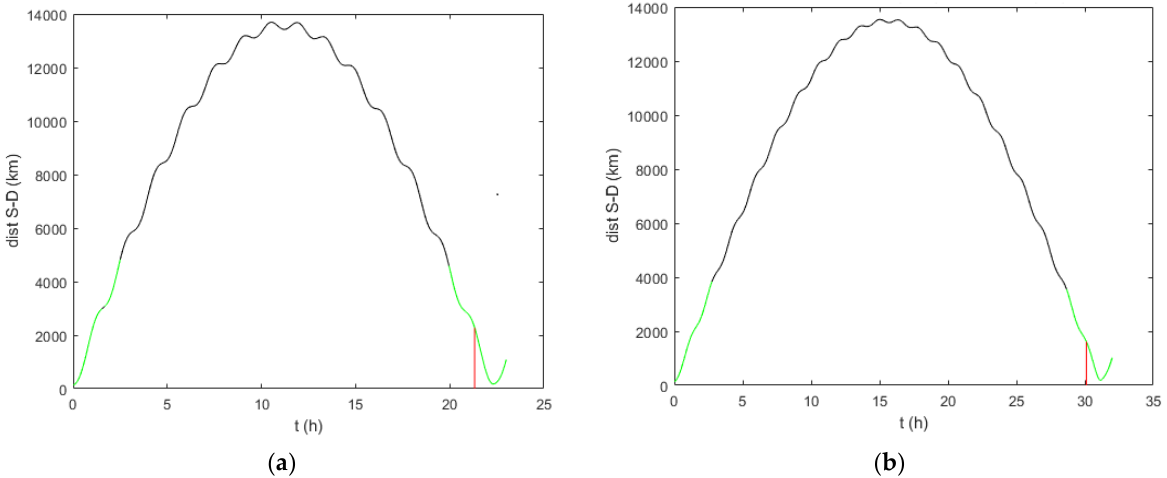
Figure 4. N distances from S to D with shooting actions: ( a ) Case 2, ( b ) Case 4.